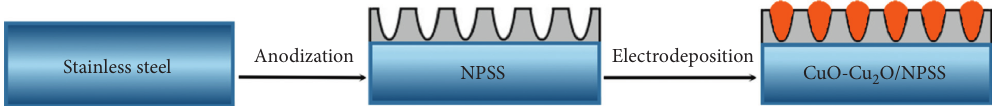
Figure 1: Schematic illustration of the procedure for preparing CuO-Cu